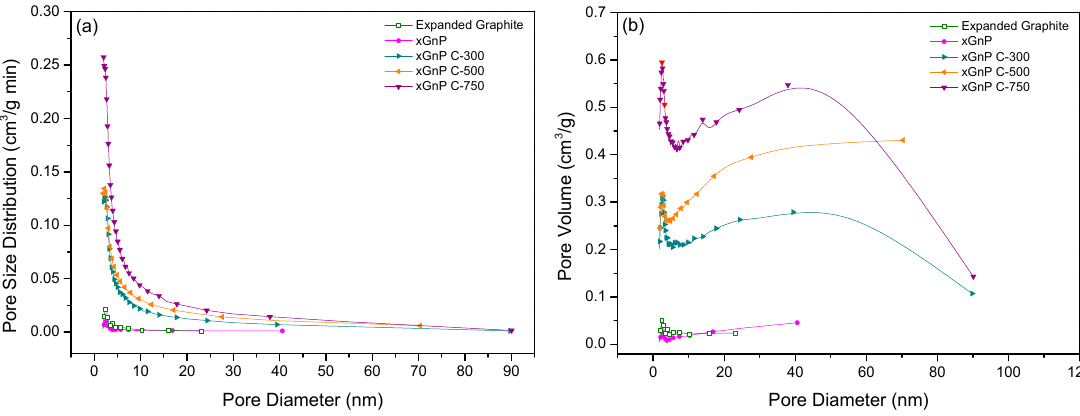
Figure 3. Pore diameter isotherms of porous carbon materials: ( a ) pore size distribution and ( b ) pore volume.